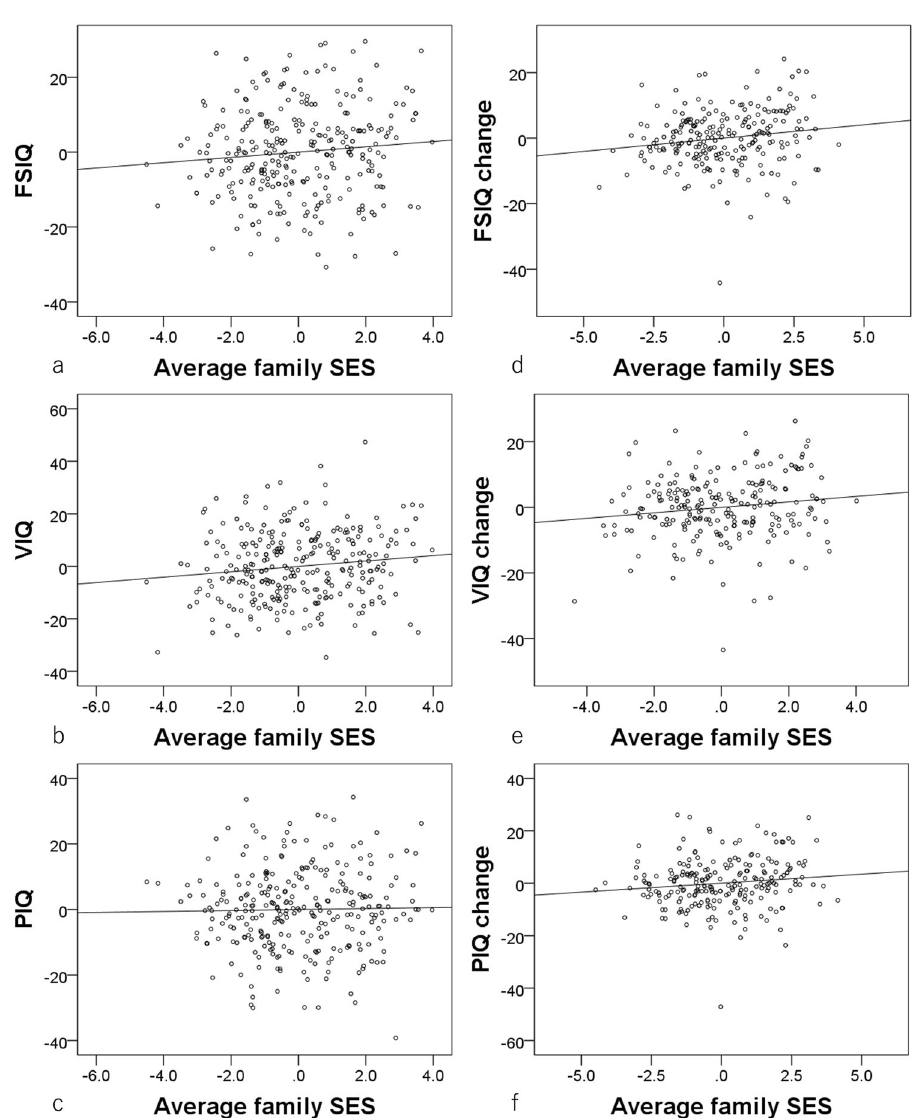
Fig. 2 Associations between childhood SES and IQ measures, as well as changes across time. a – c Residual plots with trend lines depicting the correlations between residuals in multiple regression analyses with ( a ) FSIQ (signi fi cant, N = 284), ( b ) VIQ (signi fi cant, N = 284), and ( c ) PIQ (insigni fi cant, N = 285) at baseline as a dependent variable, and childhood SES at baseline and other confounding factors as independent variables. d – f Residual plots with trend lines depicting the correlations between residuals in multiple regression analyses with baseline to follow-up experiment changes in (d) FSIQ (signi fi cant, N = 225), ( e ) VIQ (signi fi cant, N = 225), and ( f ) PIQ (insigni fi cant, N = 225) as the dependent variables and childhood SES at baseline and other confounding factors as independent variables. Table 2 Statistical values of associations between childhood SES and psychometric intelligence measures (cross-sectional multiple regression analyses) or their longitudinal changes (longitudinal multiple regression analyses). Cross-sectional multiple regression analyses, Longitudinal multiple regression analyses, Dependent